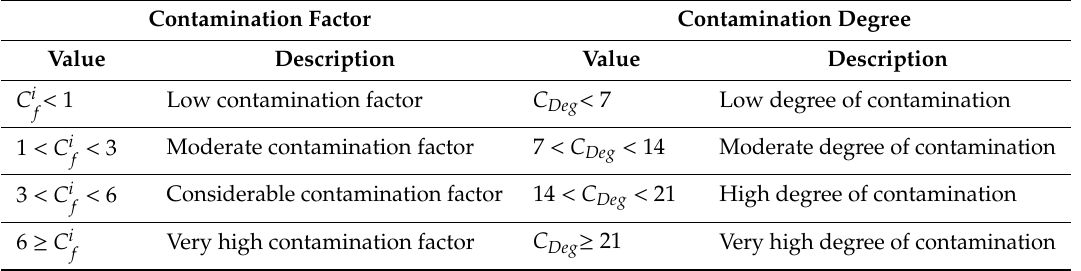
Table 3. Contamination factor and degree and their respective